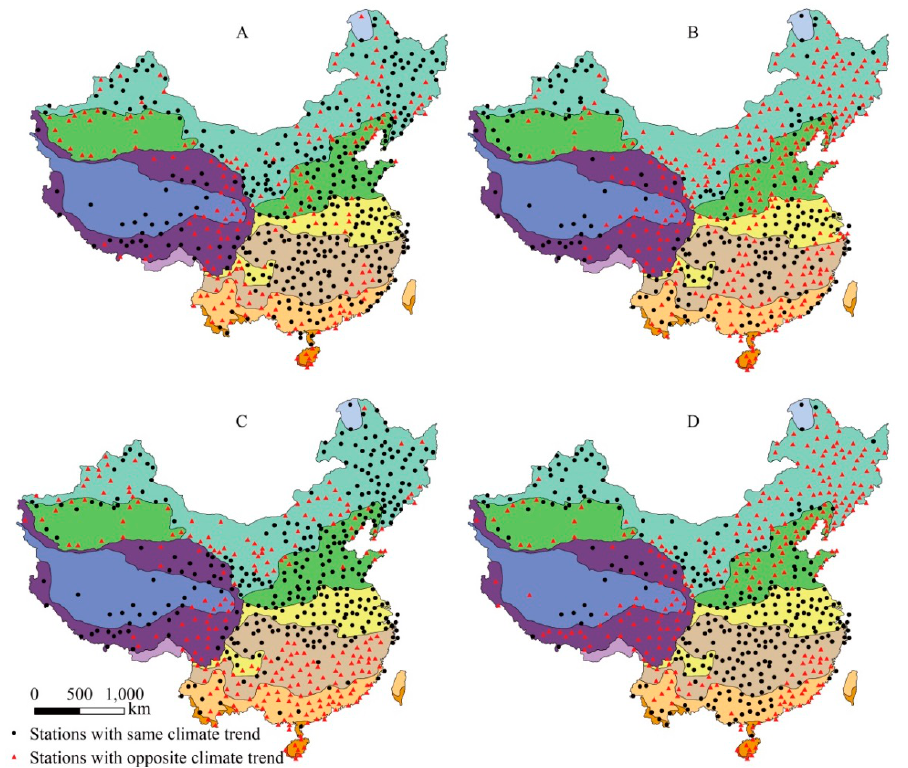
Figure 9. Climate trend of monthly minimum temperature for January ( A ), April ( B ), July ( C ) and October ( D ).